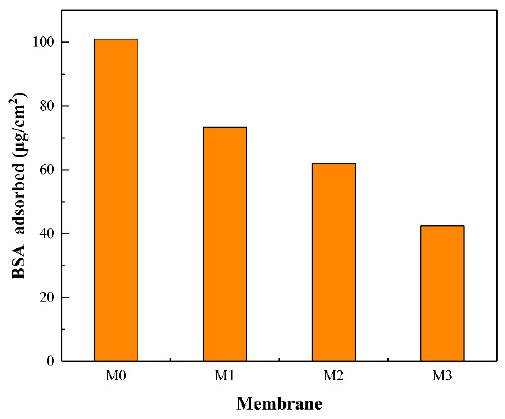
Figure 8. The amount of BSA adsorbed by the prepared membranes.